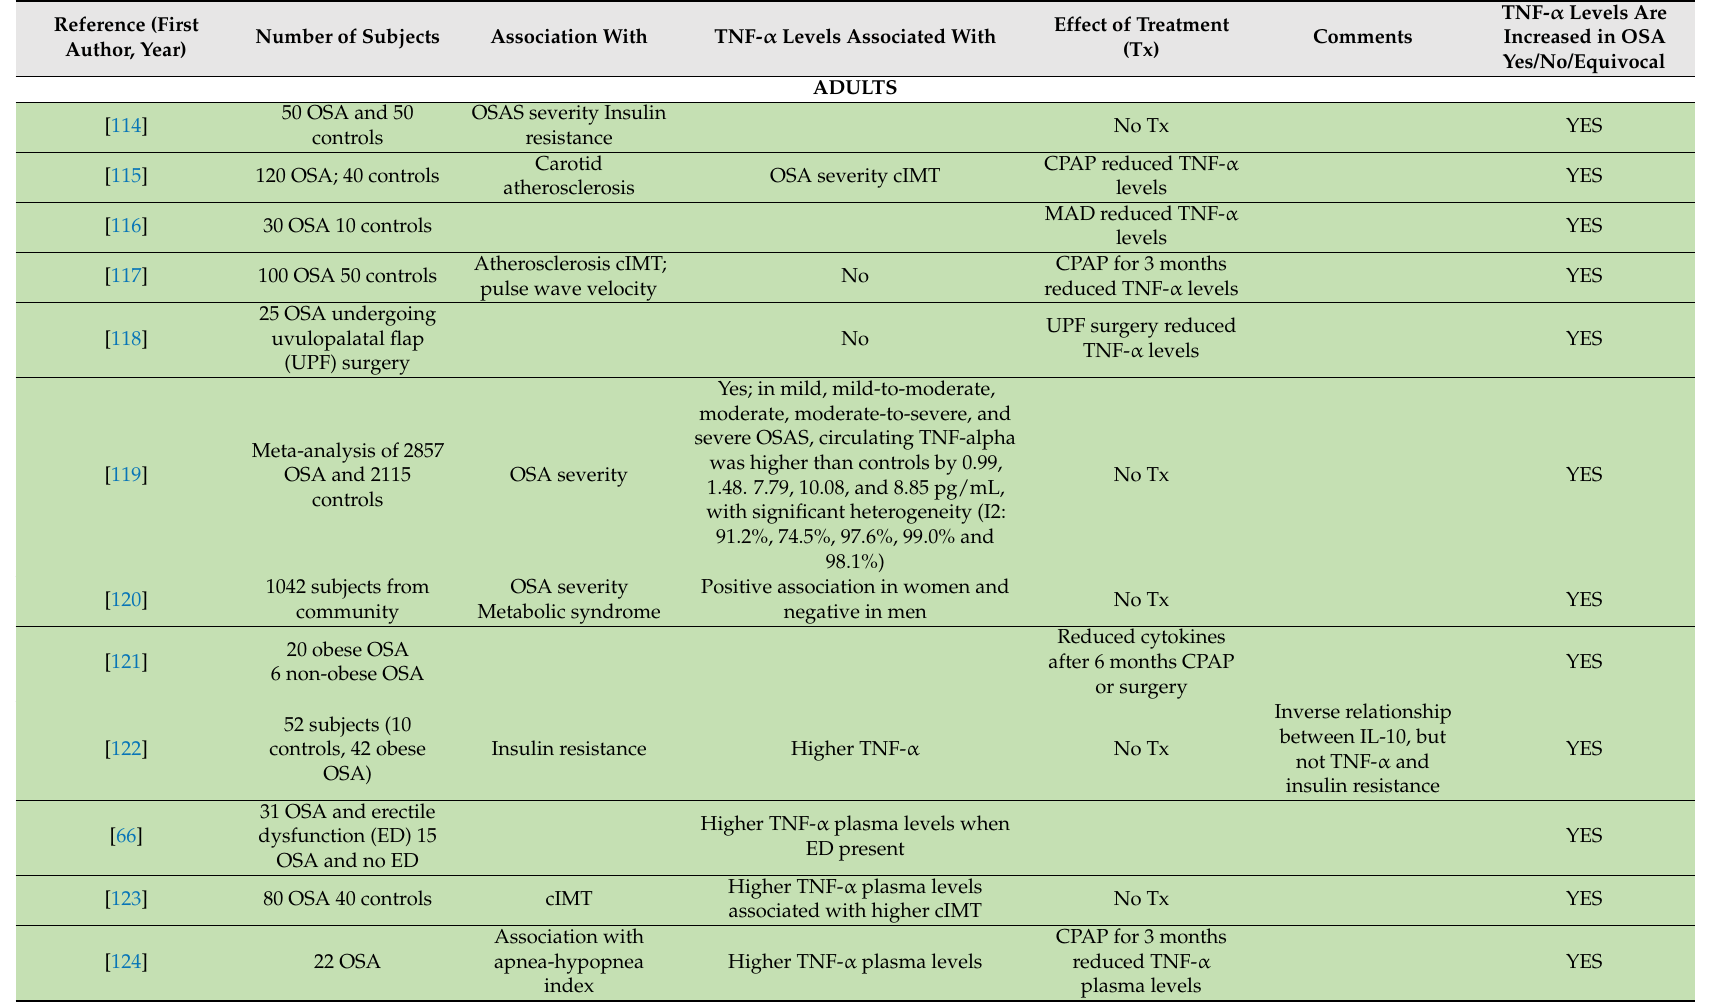
Table 1. Summary of published studies examining TNF- α serum concentrations in adults and children with obstructive sleep apnea syndrome (OSAS) over the last 15 years. Green rows indicate significant findings, orange rows indicate negative findings, and yellow rows reflect equivocal